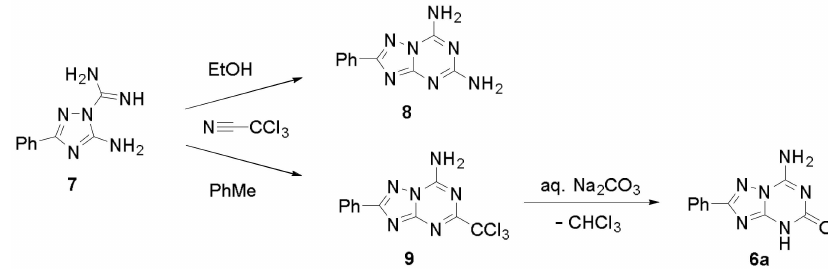
Scheme 3. Synthesis of 5-aza-isoguanine 6a